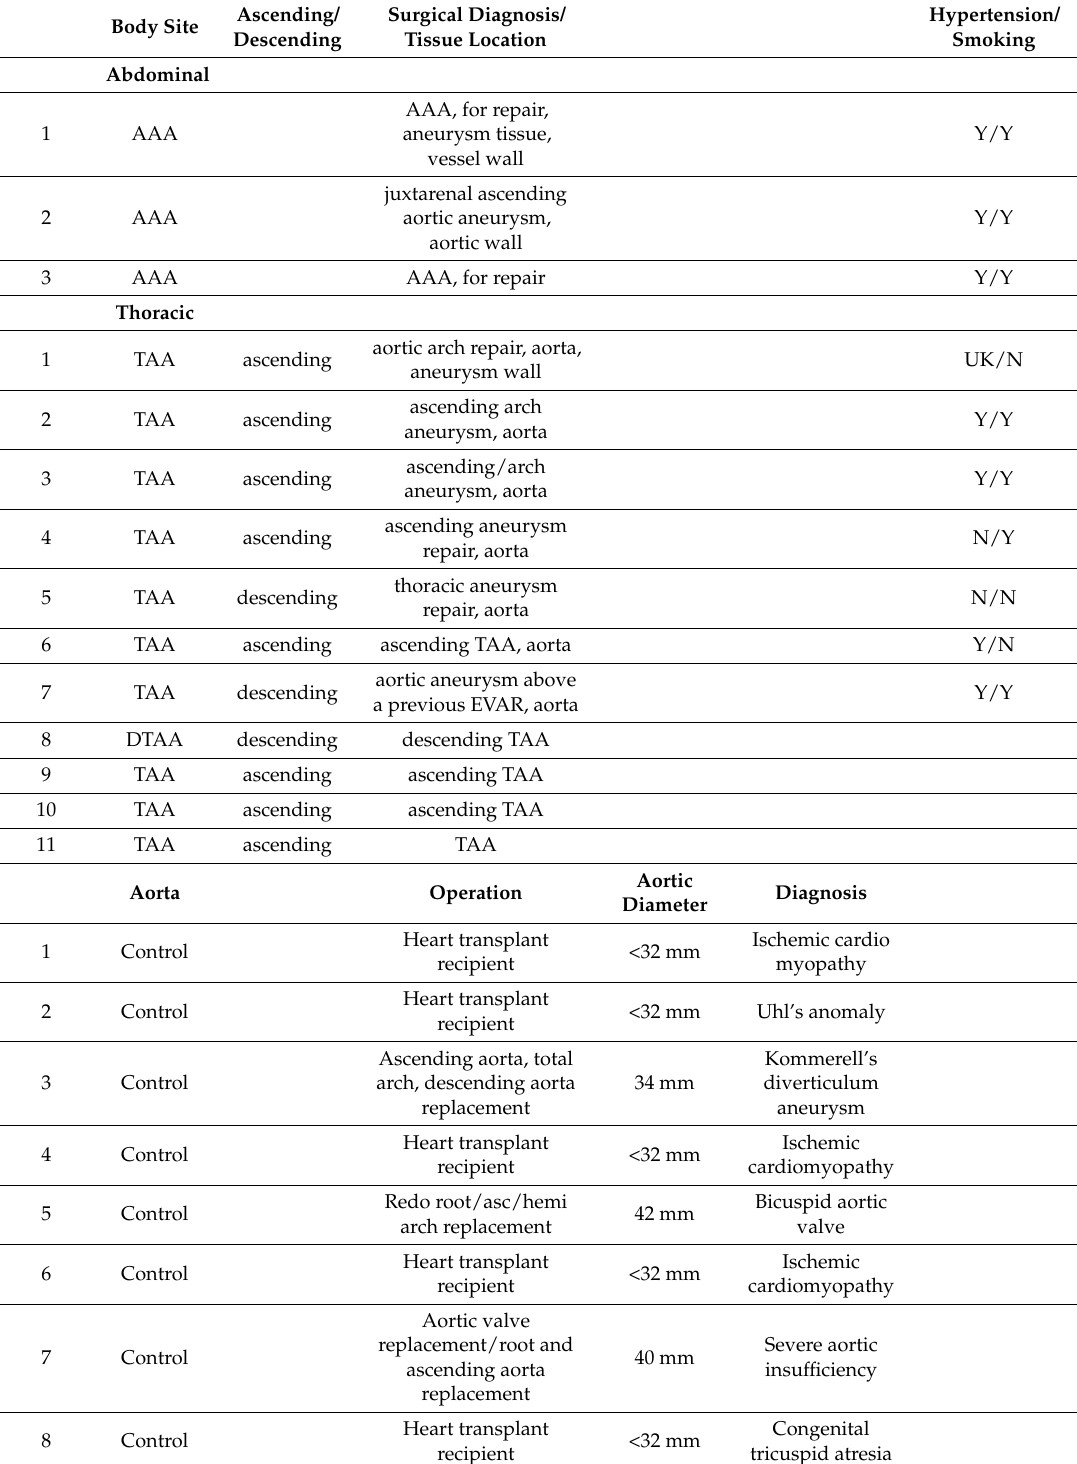
Table 1. Summary of clinical details of human tissue samples used for quantitative reverse transcription polymerase chain reaction (qRT-PCR) and microarray